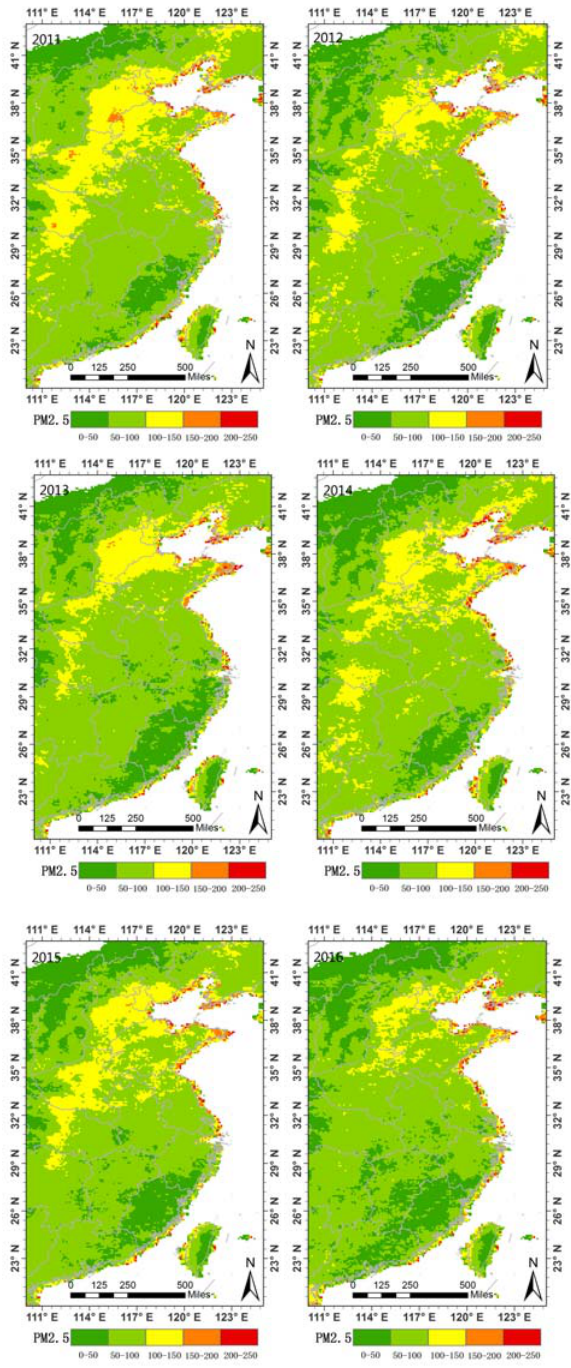
Figure 2. Annual averaged PM 2.5 Concentration in Central and Eastern China from 2007 to